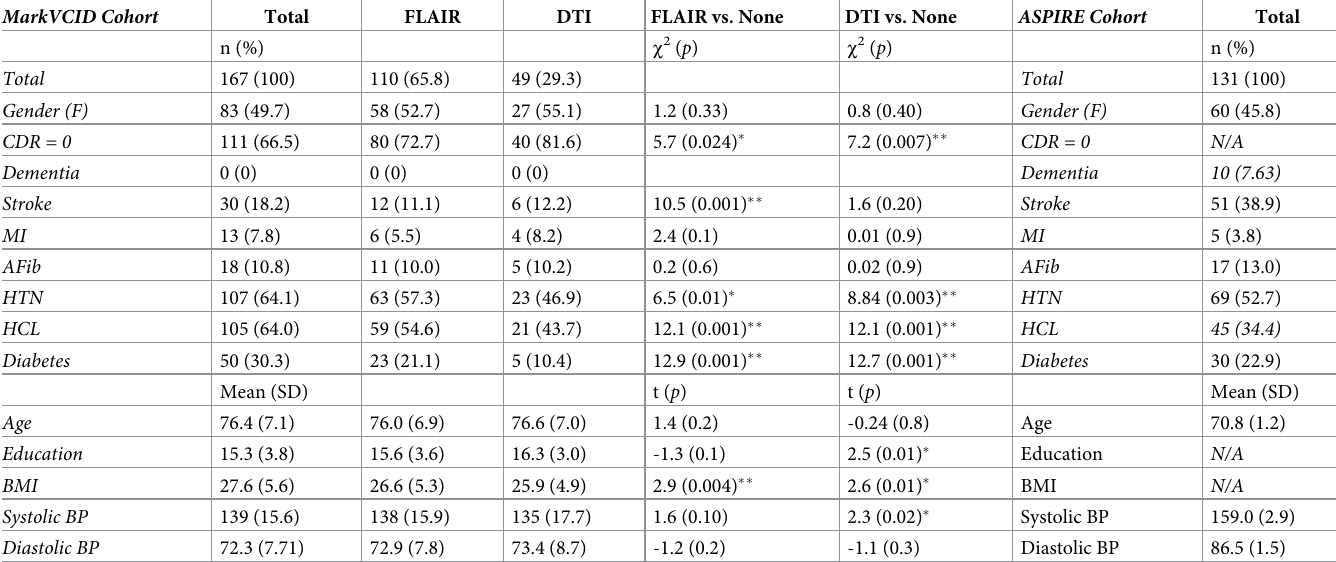
Demographic and vascular health information for 167 MarkVCID Cohort participants and 131 ASPIRE Cohort participants. Chi squared and T-tests evaluated the group differences between MarkVCID Cohort participants with FLAIR imaging or DTI, and those without. Overall, participants with brain imaging had better vascular and cognitive health. Missing data for Mark VCID: Stroke ( n = 2), HCL ( n = 3), Diabetes ( n = 2). F = Female, CDR = Clinical Dementia Rating, MI = Myocardial Infarction, AFib = Atrial Fibrillation, HTN = Hypertension, HCL = Hypercholesterolemia, BMI = Body Mass Index, BP = Blood Pressure